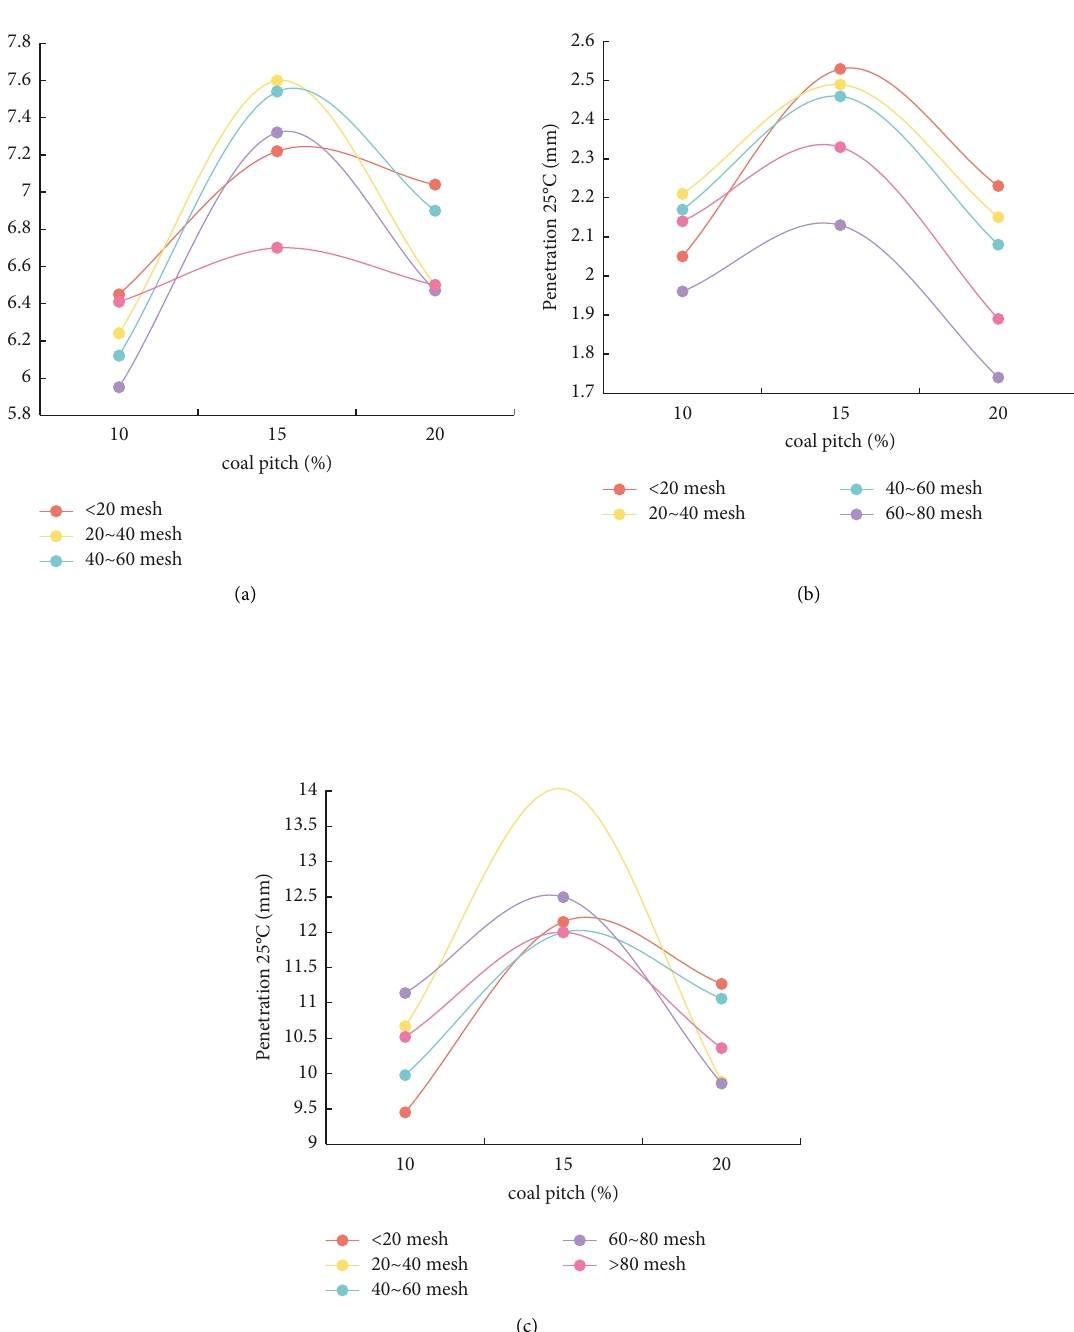
Figure 8: The influence of different temperatures on the penetration of the modified asphalt. (a) The influence of nano-calcium carbonates doping on the penetration of modified asphalt at 25 ° C. (b) The effect of nano-calcium carbonates doping on the penetration of modified asphalt at 15 ° C. (c) The effect of nano-calcium carbonates doping on the penetration of modified asphalt at 30 °